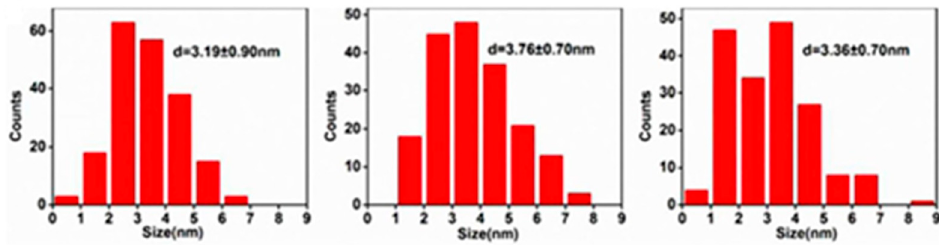
Figure 16. Size ‐ distribution images for GQDs ‐ PBS, GQDs ‐ NaOH, and GQDs ‐ KCl. Reprinted with permission from Ref.